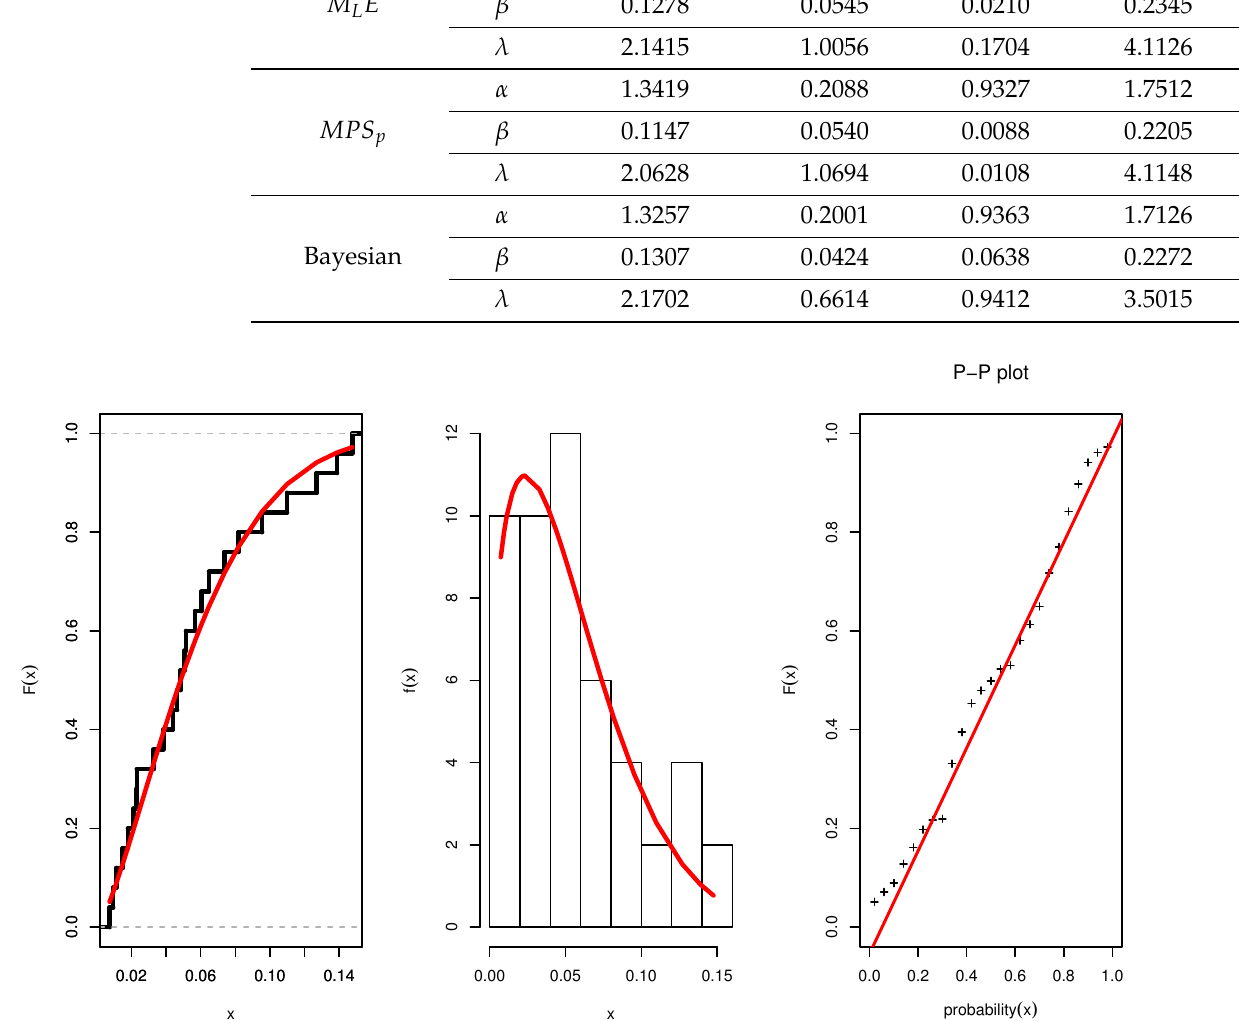
Figure 3. Estimated pdf, CDF, and P-P plots of UEP for the recovery rate of COVID-19 data from